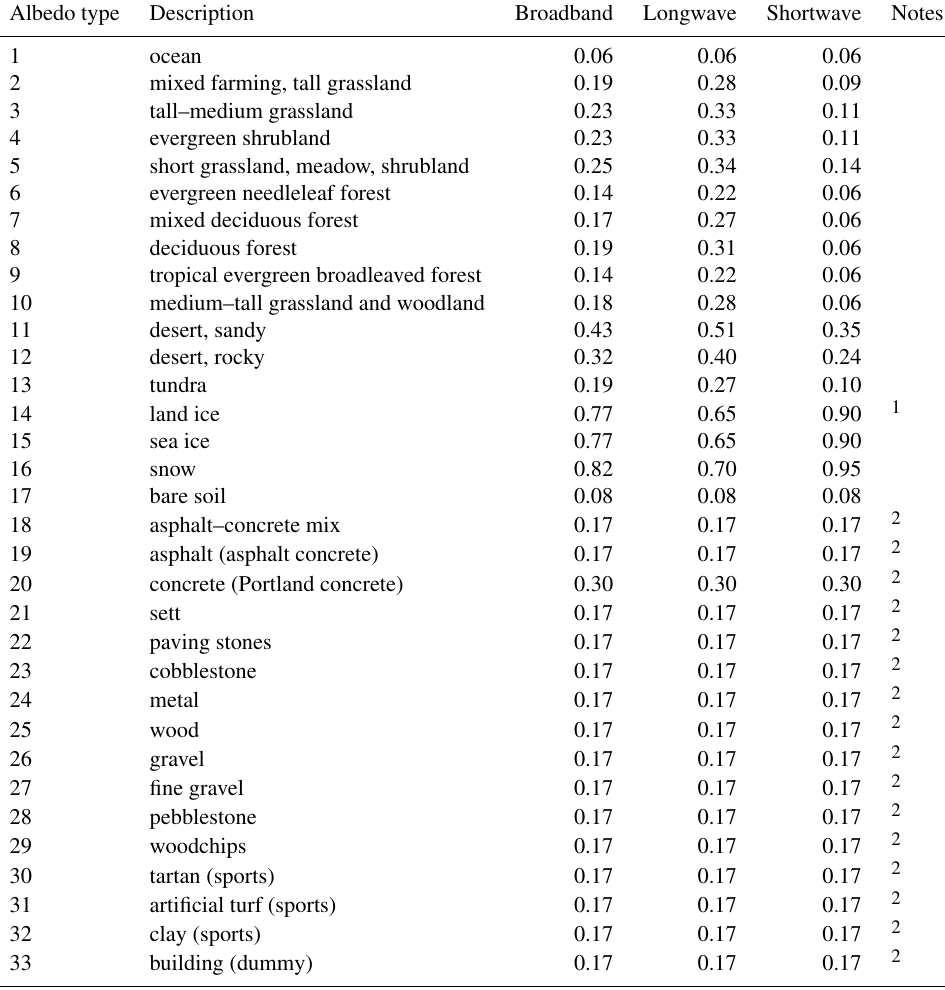
Table 3. Lookup table for albedo